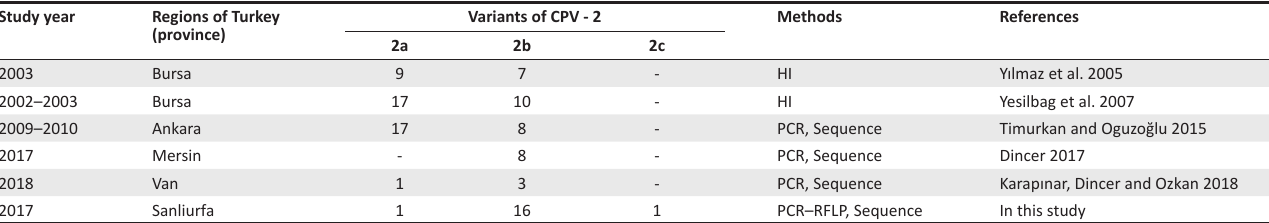
TABLE 1: Studies of canine parvovirus -2 genotyping of dogs in Turkey. Study